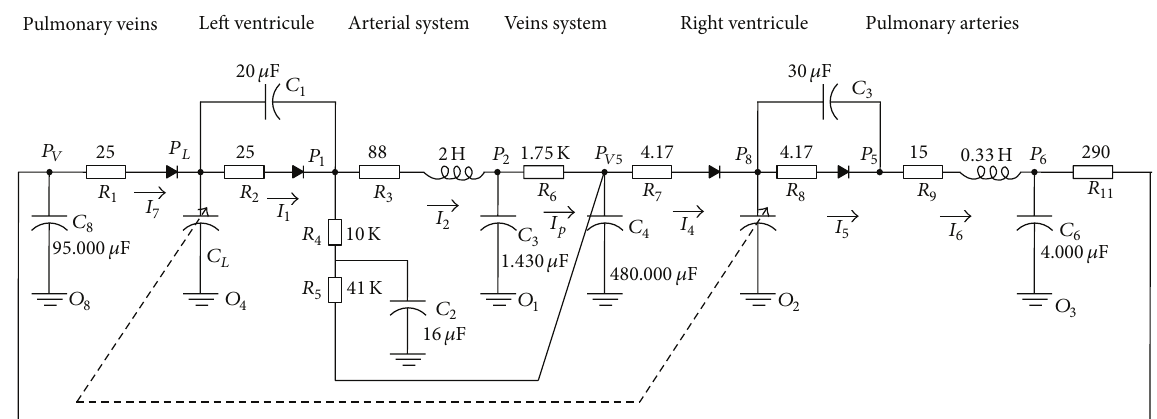
Figure 12: Analog circuit for human systemic circulatory system.